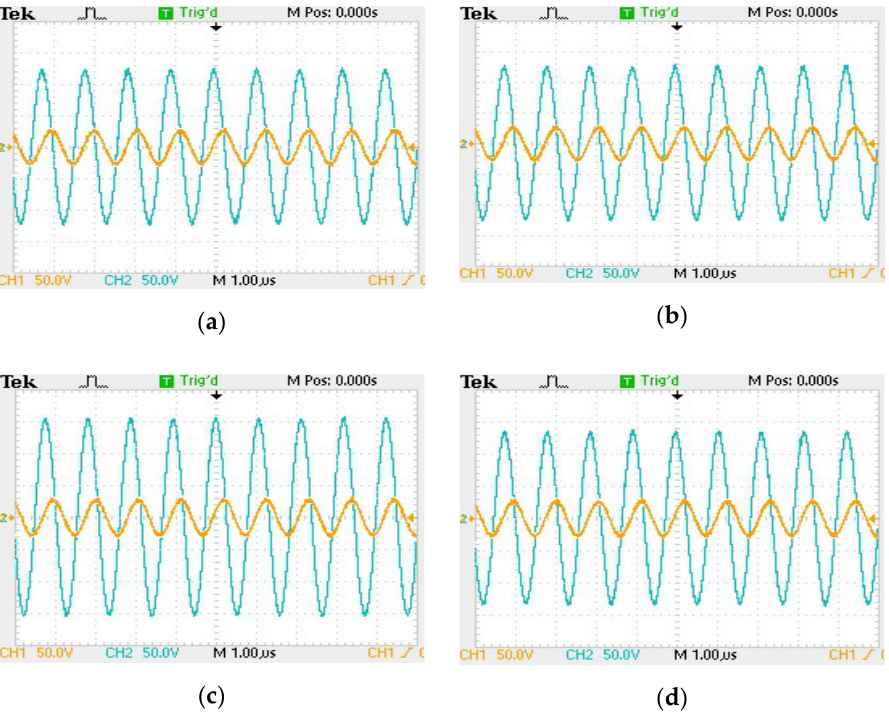
Figure 13. Input voltage (CH1) and output voltage (CH2) of first design: ( a ) α = 0°; ( b ) α = 30°; ( c ) α = 60°; ( d ) α = 85°.